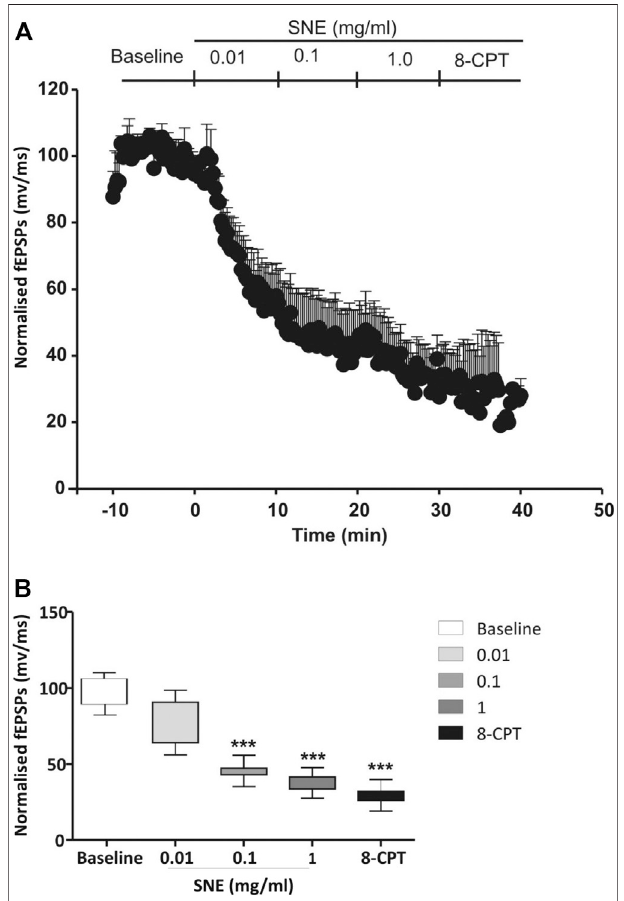
FIGURE 6 | (A) Administration of 8-CPT (4 µM) after SNE (0.01, 0.1 and 1.0 mg/ml) on slope of fEPSPs in rat hippocampal slices after a stable baseline perfused with normal aCSF. (B) The box and whiskers graph is the total effect calculated form the AUCs of the graph above it. Data is mean ± SEM (n (cid:2) 3). *** p < 0.001 compared with baseline, one-way ANOVA followed by a Dunnett ’ s multiple comparison test.